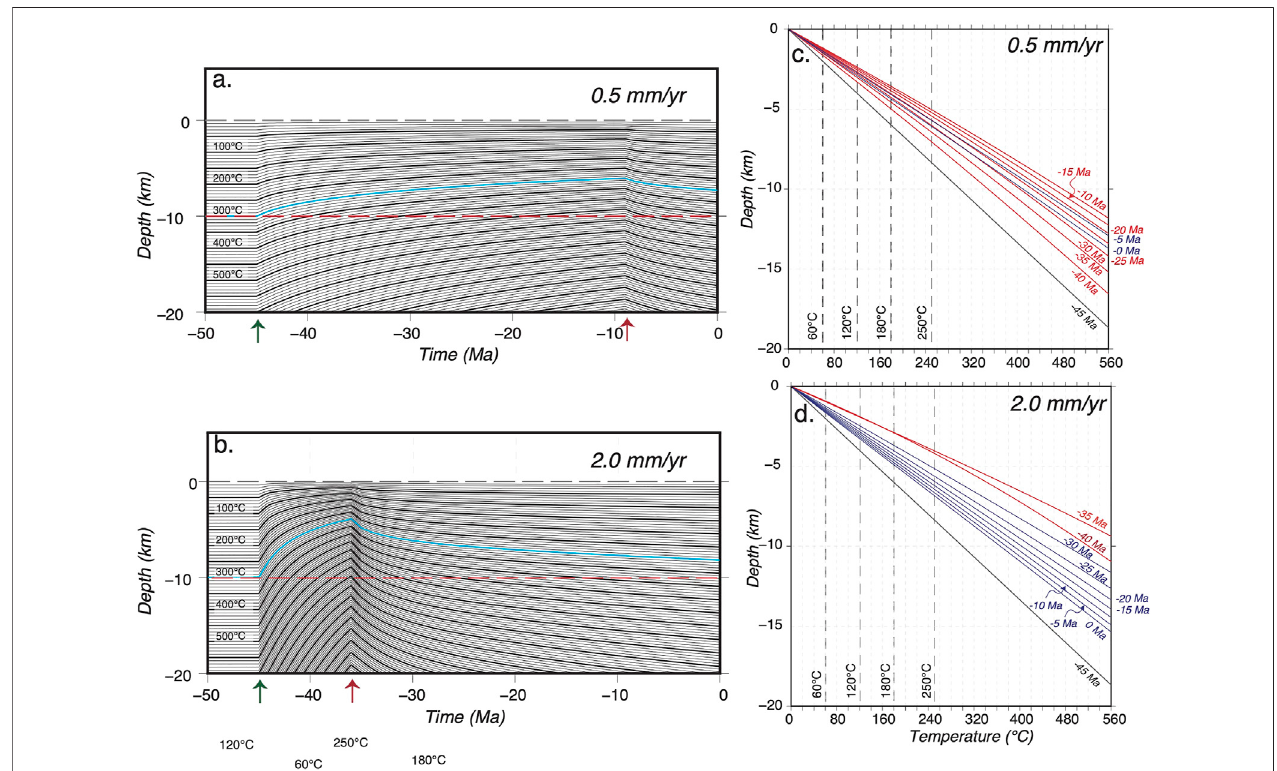
FIGURE 4 | Transient thermal response to a single exhumation event. Comparison between slower (0.5 mm/yr) and faster (2.0 mm/yr) exhumation rates. Results are for models shown in Figure 3 . In both cases total exhumation is 18 km. Arrows along time-line indicate the start (green) and end (red) of the exhumation event. Left panels (A,C) showthebehaviorofisothermsduringandafterexhumation.Thebluelinetracesthe300 ° Cisotherm;thereddashedlinemapsthe10 kmdepthlevel.Right panels (B,D) showgeothermsatvarioustimesthroughthethermalevolution.Redgeothermsareduringtheexhumationeventandbluegeothermsareaftertheend of exhumation when the thermal fi eld is relaxing toward